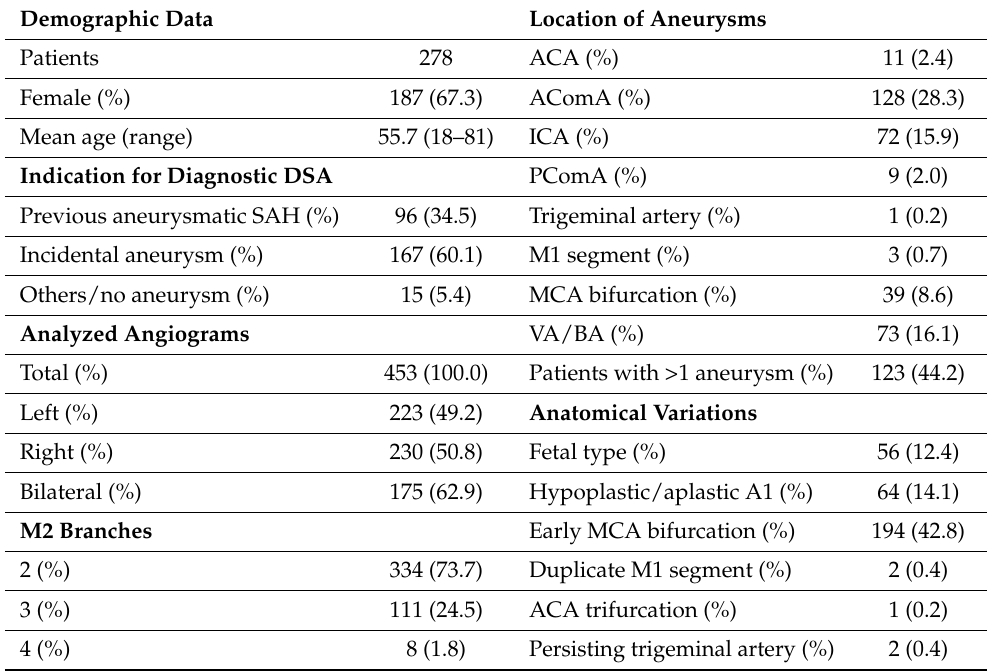
Table 1. Baseline